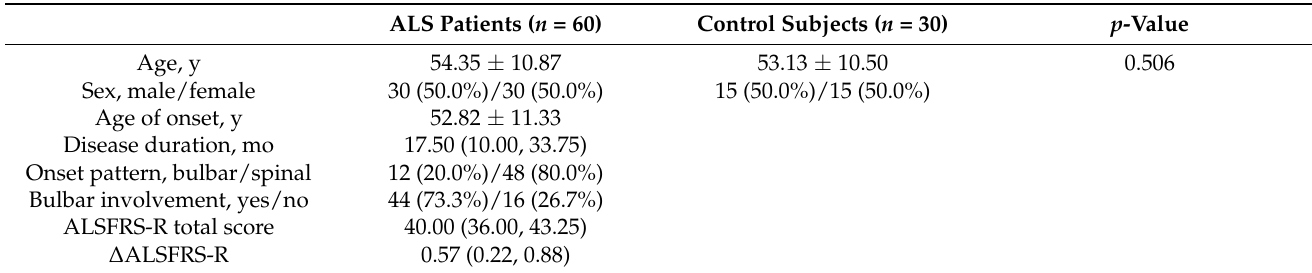
Table 1. Demographic and clinical characteristics of ALS patients and control subjects.